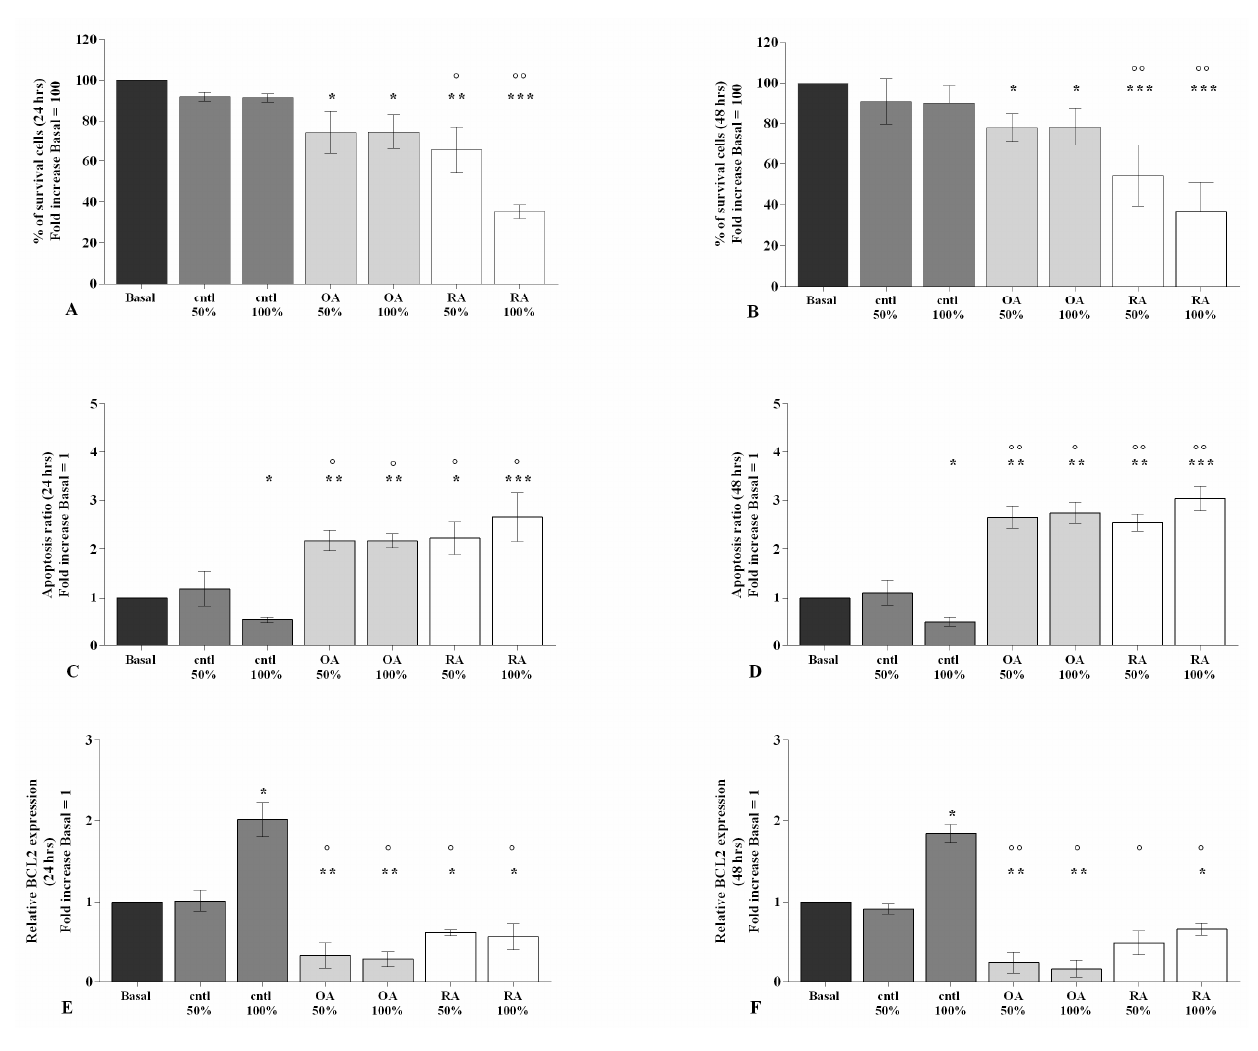
Figure 1. SF regulates viability and apoptosis. Human osteoarthritic (OA) chondrocytes were incubated for 24 h and 48 h with 50% and 100% SF derived from patients with OA, rheumatoid arthritis (RA), or controls. ( A , B ) Evaluation of cell viability by MTT assay. ( C , D ) Apoptosis detection performed by flow cytometry analysis and measured with annexin Alexa fluor 488 assay. Data were expressed as the percentage of positive cells for annexin-V and propidium iodide (PI) staining. ( E , F ) Expression levels of B-cell lymphoma ( BCL2 ) analyzed by quantitative real-time PCR. The percentage of survival cells, the ratio of apoptosis, and the gene expression were referenced to the ratio of the value of interest and the value of basal condition, reported equal to 100 or 1. Data were represented as mean ± SD of triplicate values. * p < 0.05, ** p < 0.01, *** p < 0.001 versus basal condition. ° p < 0.05, °° p < 0.01 versus control SF.